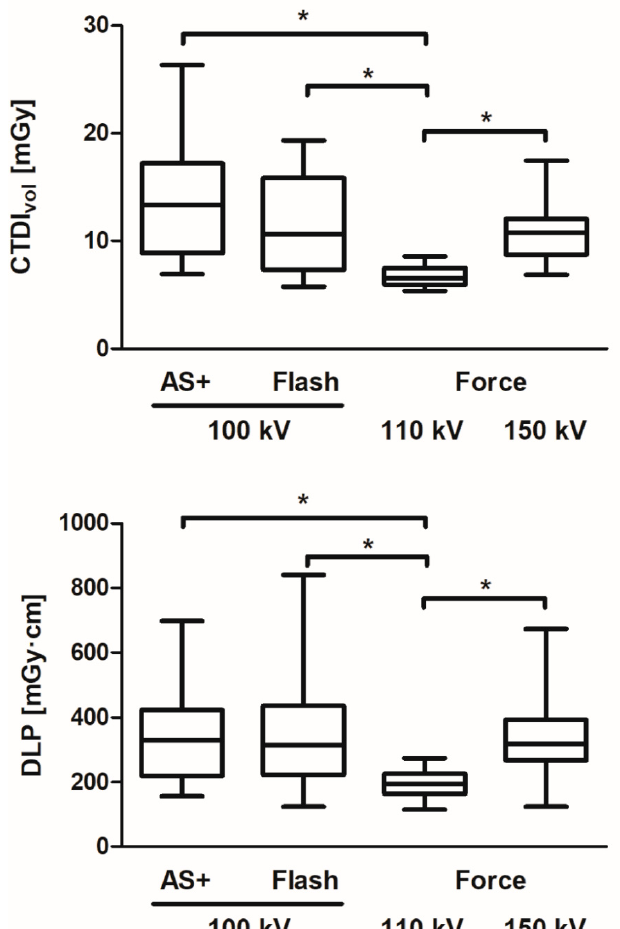
Figure 4. Comparison of radiation exposure in terms of volume-weighted CT dose index (CTDIvol) and dose-length product (DLP) of different CT myelography protocols for the lumbar spine on different CT scanners. AS+: SOMATOM Definition AS+; Flash: SOMATOM Definition Flash; Force: SOMATOM Force (all: Siemens Healthineers, Forchheim, Germany). Indication of tube voltage in kV refers to the applied protocols (Table 1). An asterisk (*) indicates a significant difference.